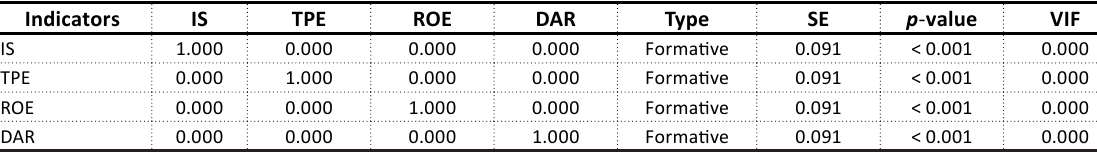
Table 1. Results of weight indicator evaluation